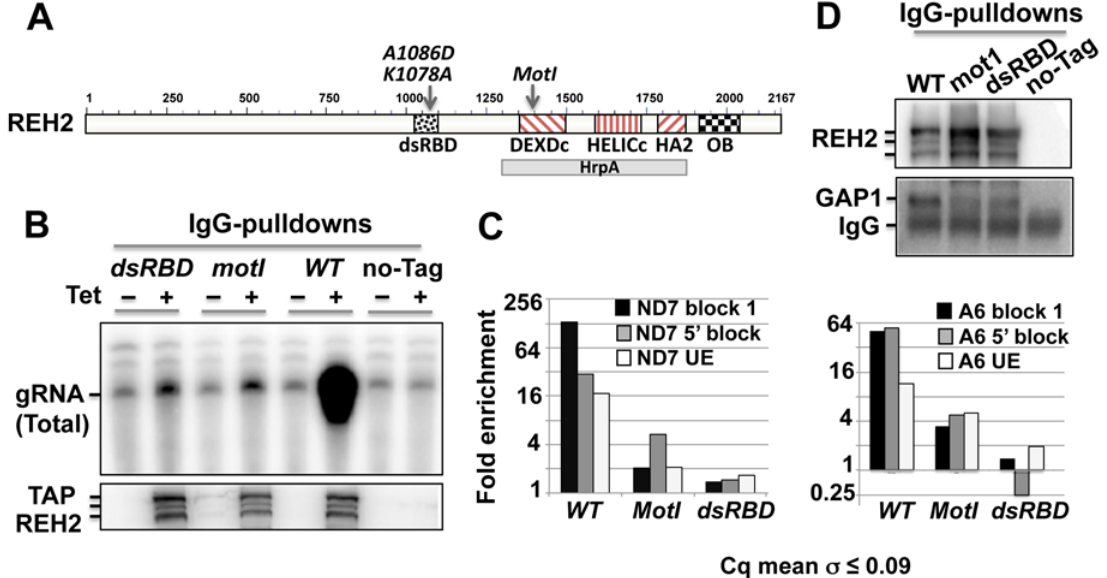
Fig 10. Association of REH2 with components of its MRB requires normal conserved domains. (A) REH2 (2,167 amino acids) includes the double- stranded RNA binding (dsRBD) and DExH-helicase domains, and an OB-fold domain not previously identified. Expressed TAP-tagged REH2 variants in Dynabead IgG pulldowns were tested for (B) gRNA in radiolabeled capping assays of the 5 ’ triphosphate, (C) fold enrichment of edited mRNA at block 1 or at a distal block, and unedited pre-mRNA. RT-qPCR assays were normalized to values in the untagged REH2 pulldown set at 1. Tubulin and 18S rRNA carryover were used as reference, (D) GAP1 and REH2 in western blots. Cells-/+ Tet induction of wild-type (WT), mutants, or untagged REH2 (no-Tag) were compared. Standard deviation of the average value in Cq duplicates is